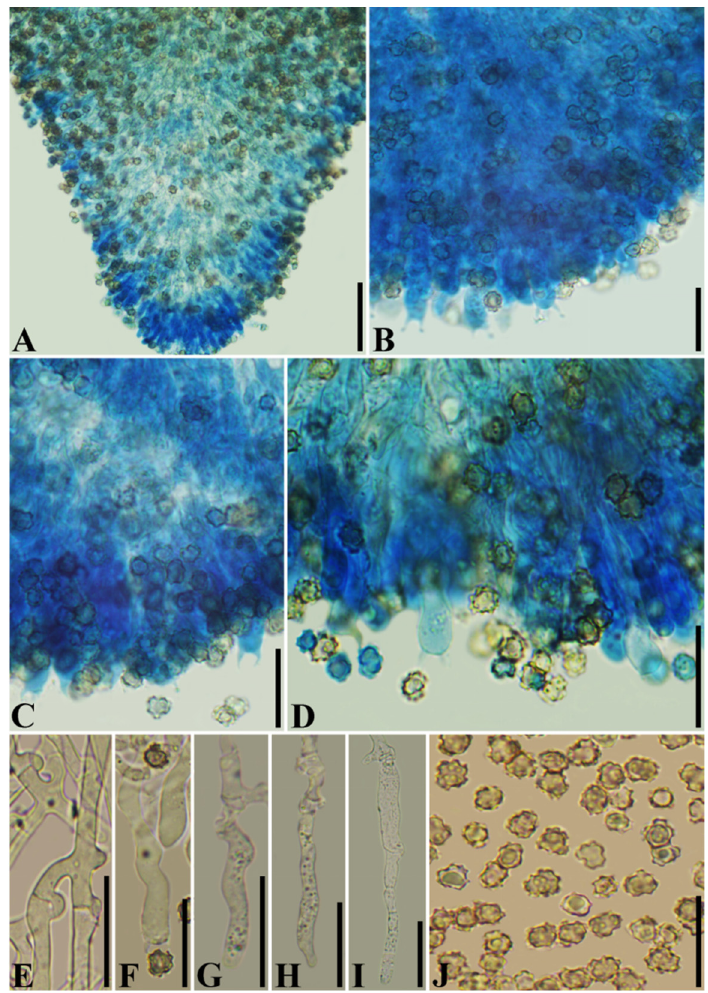
Figure 8. Microscopic structures of Thelephora grandinioides (holotype CLZhao 3406). ( A ) A section